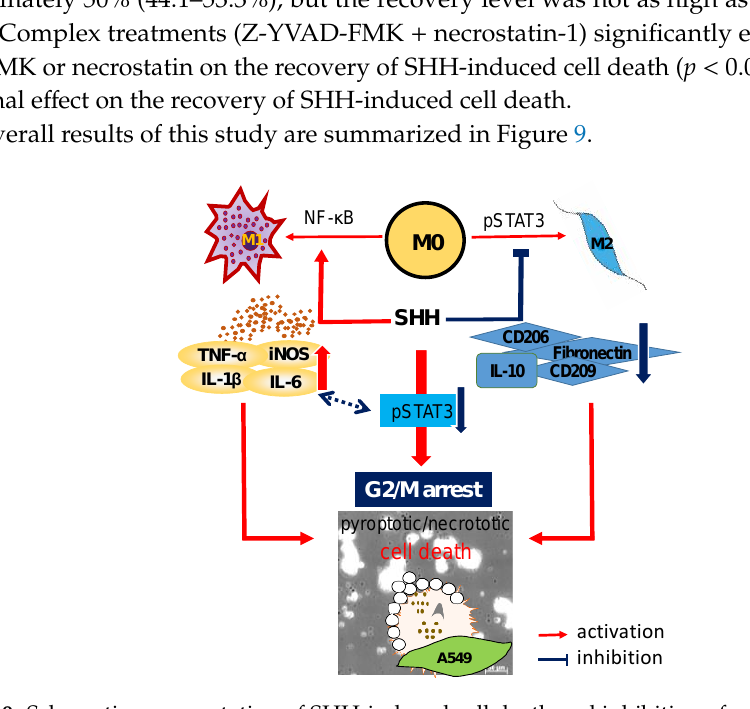
Figure 9. Schematic representation of SHH-induced cell death and inhibition of cell growth of A549. SHH inhibits STAT3 activation, which blocks the activation of p53 and its downstream activation of p21 and p27, and the inhibition of cyclin B1. Finally, G2 / M phase arrest occurred. SHH treatment induces M1 activation and M2 suppression, which cause cancer cell death, through molecules secreted from macrophages. SHH-induced cell death is caused by IL-1 β -mediated cell death mechanisms, which is preceded by caspase-1 activation. The blue two-way dotted arrows represent each other’s crosstalk. Pro-inflammatory cytokines may induce suppression of pSTAT3, and low pSTAT3 activity may induces M1 activation, which increases the secretion of pro-inflammatory cytokines.